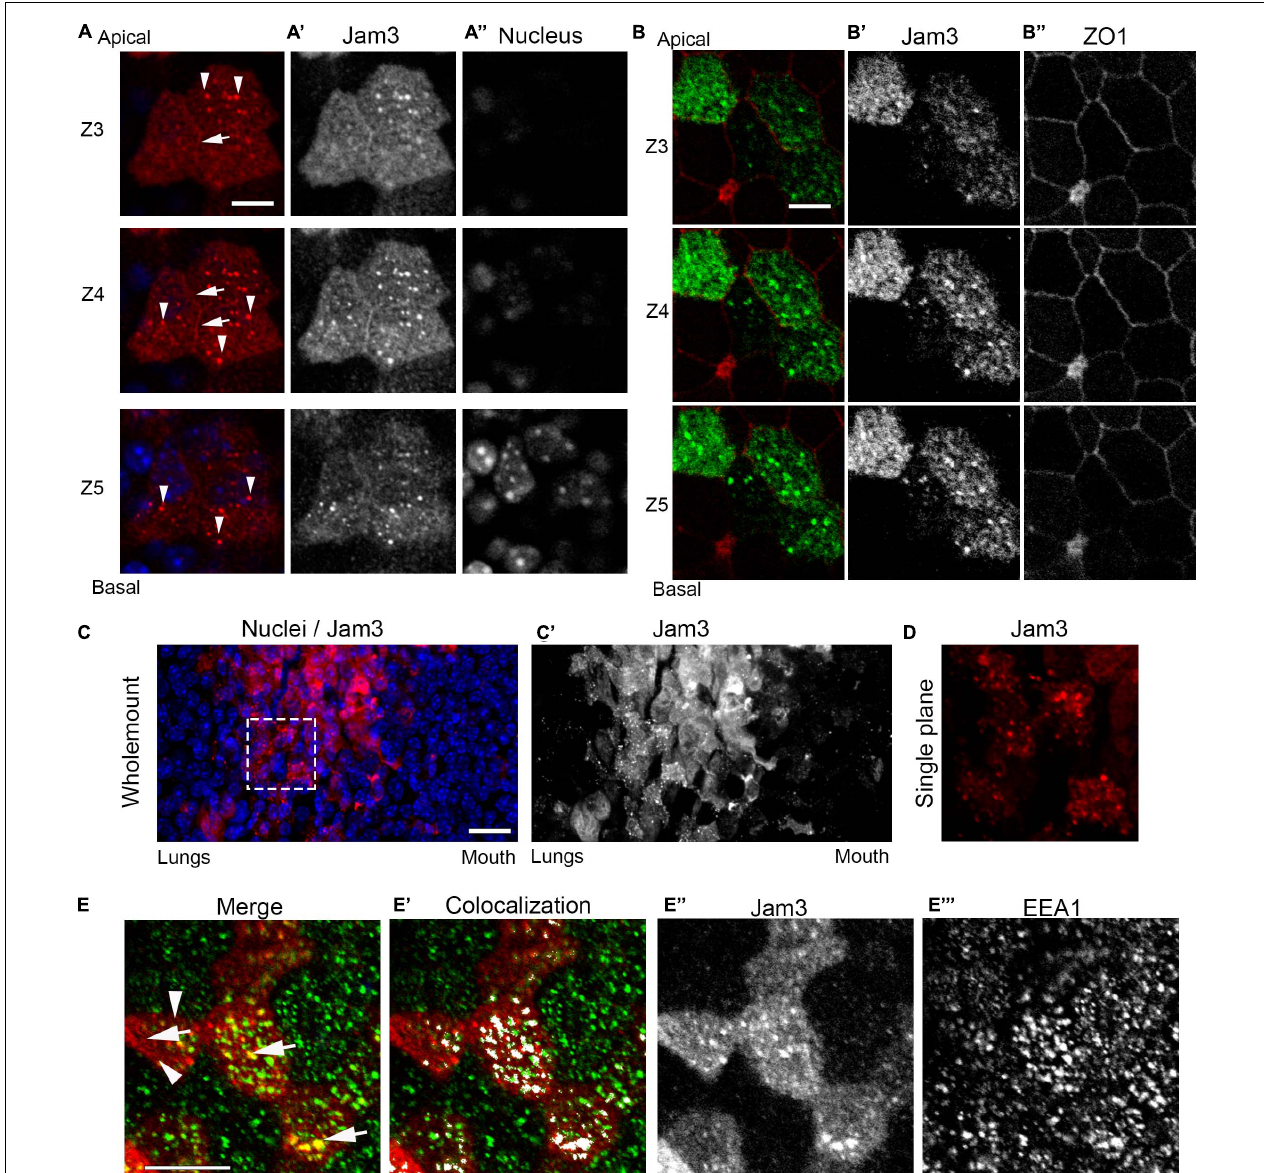
FIGURE 3 | Junctional adhesion molecule 3 (Jam3) localizes at cell–cell contacts and in apical sorting endosomes. (A) Confocal Z-planes from apical to more basal ones (Z3 to Z5) of Jam3 in MCCs. White arrows point to Jam3 localization at cell contacts, and white arrowheads denoted Jam3 localization in apically located endosomes. Jam3 in red (gray in panel A’), and nucleus in blue (gray in panel A”). (B) Serial confocal Z-planes (Z3 to Z5) of Jam3 co-localization with ZO1 in MCCs. Jam3 in green (gray in panel B’), and ZO1 in red (gray in panel B”). (C) Immunofluorescence in mouse whole-mount trachea for Jam3 in red (gray in panel C’ ) and nuclei in blue. (D) A zoom for a region of interest from panel (A) showing Jam3 localization in a group of cells. (E) A single confocal plane image for Jam3 in red (gray in panel E” ) and EEA1 in green (gray in panel E”’ ) co-localization analyses (white in panel E’ ). White arrows point to Jam3 and EEA1 co-localization in endosomes, and white arrowheads denoted Jam3 endosomes which are EEA negative. Note that not all EEA1-positive endosomes are positive for Jam3. The step size between Z planes is 1 µ m. Scale bar in panels ( A,B,D ) represents 10 µ m. The dotted white box represents the ROI depicted in panel (D)